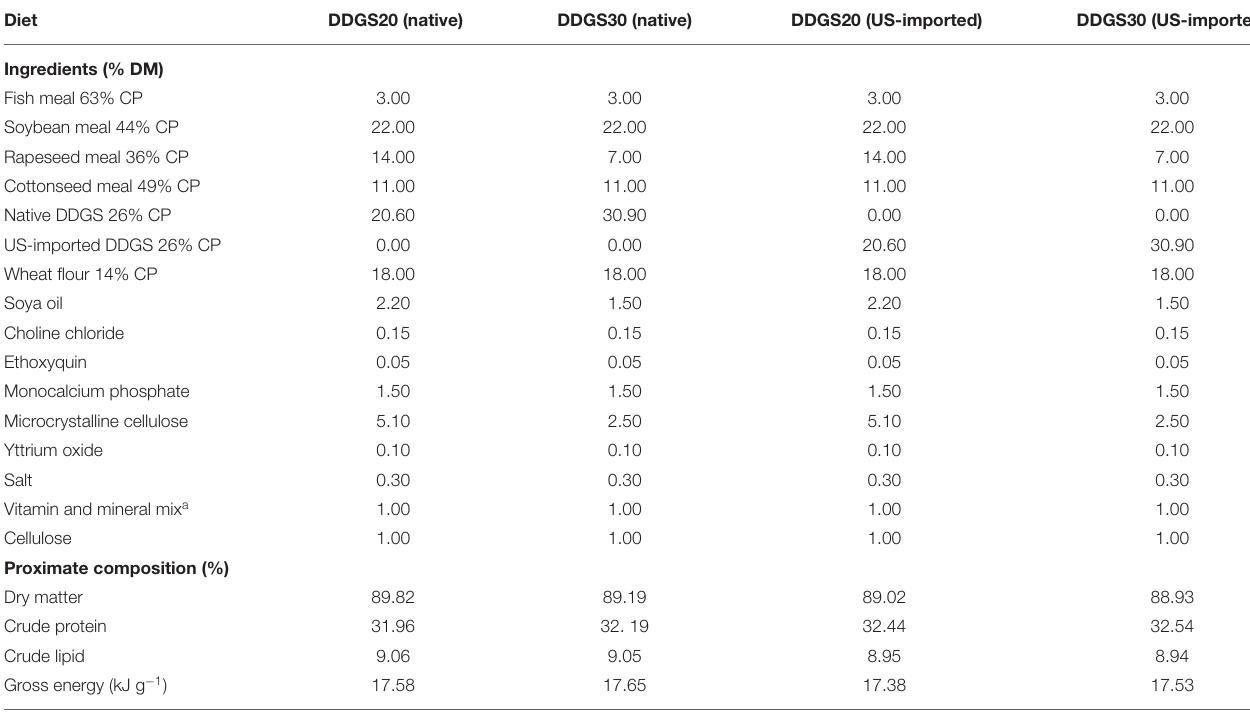
TABLE 1 | Ingredients and the proximate analysis of the experimental diets (% in dry matter) a .